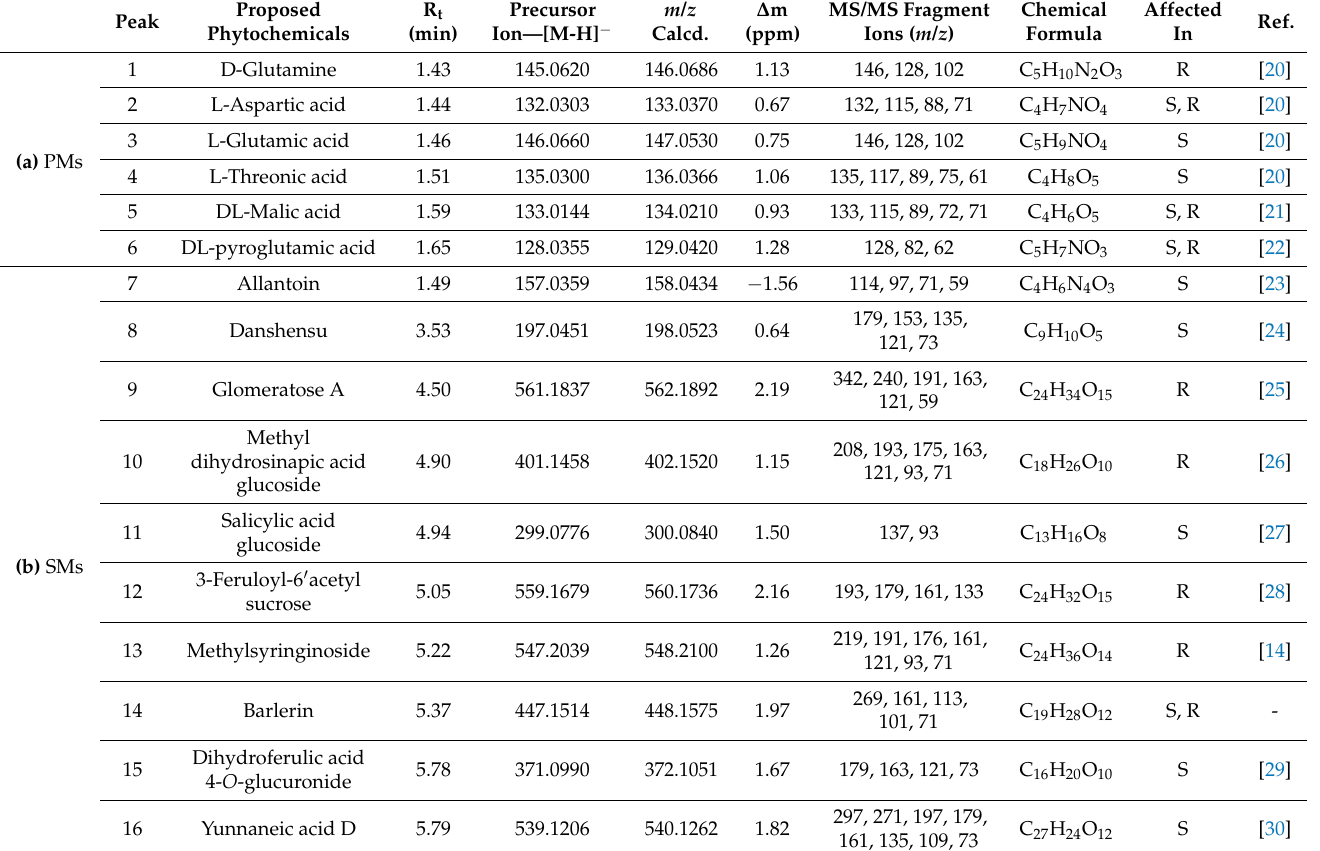
Table 2. Affected primary ( a ) and secondary metabolites ( b ) in root and shoot samples of